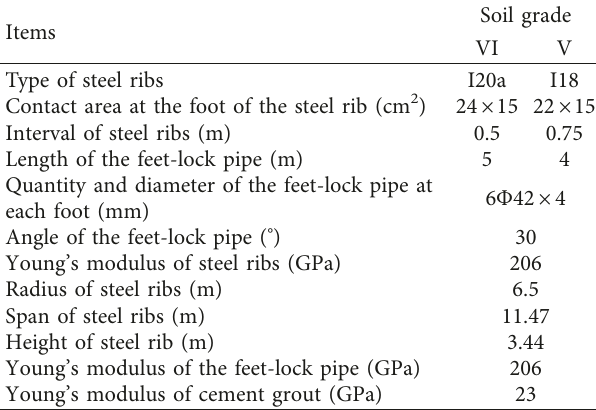
Figure 8: 2D sketch of the partial excavation method. Table 2: Basic parameters of the steel rib and the feet-lock pipe.